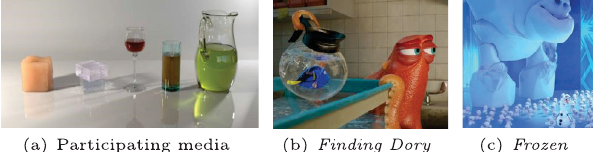
Fig. 1 Different types of participating media. (a) From Ref. [1], reproduced with permission c (cid:2) ACM 2014. (b) From “ Finding Dory ”, c (cid:2) Disney Enterprises, Inc. and Pixar, Inc. (c) From “ Frozen ”, c (cid:2) Disney Enterprises,